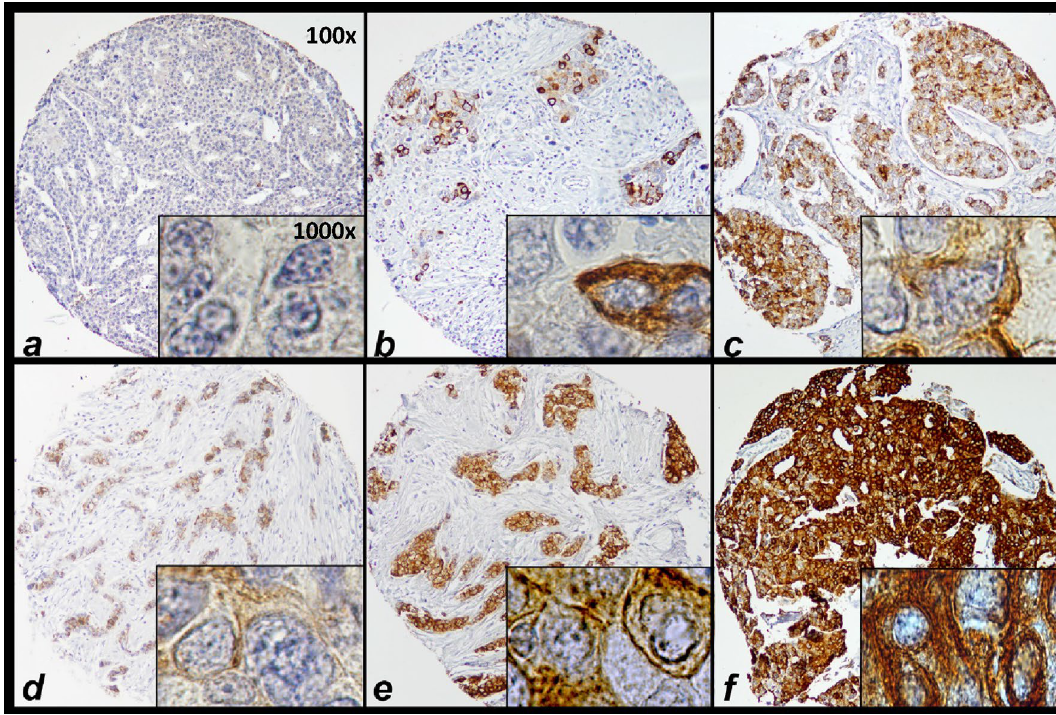
Figure 2. Scoring of immunohistochemical mGluR1 staining on TMA. Representative examples of mGluR1 staining in breast cancer tissues are shown. In these examples staining quantity (% of tumor cells) is scored as follows: ( a ) negative; ( b ) 30%; ( c ) 75%; and ( f ) 100%. Intensity is scored as follows: ( d) weak; ( e ) moderate; and ( f )